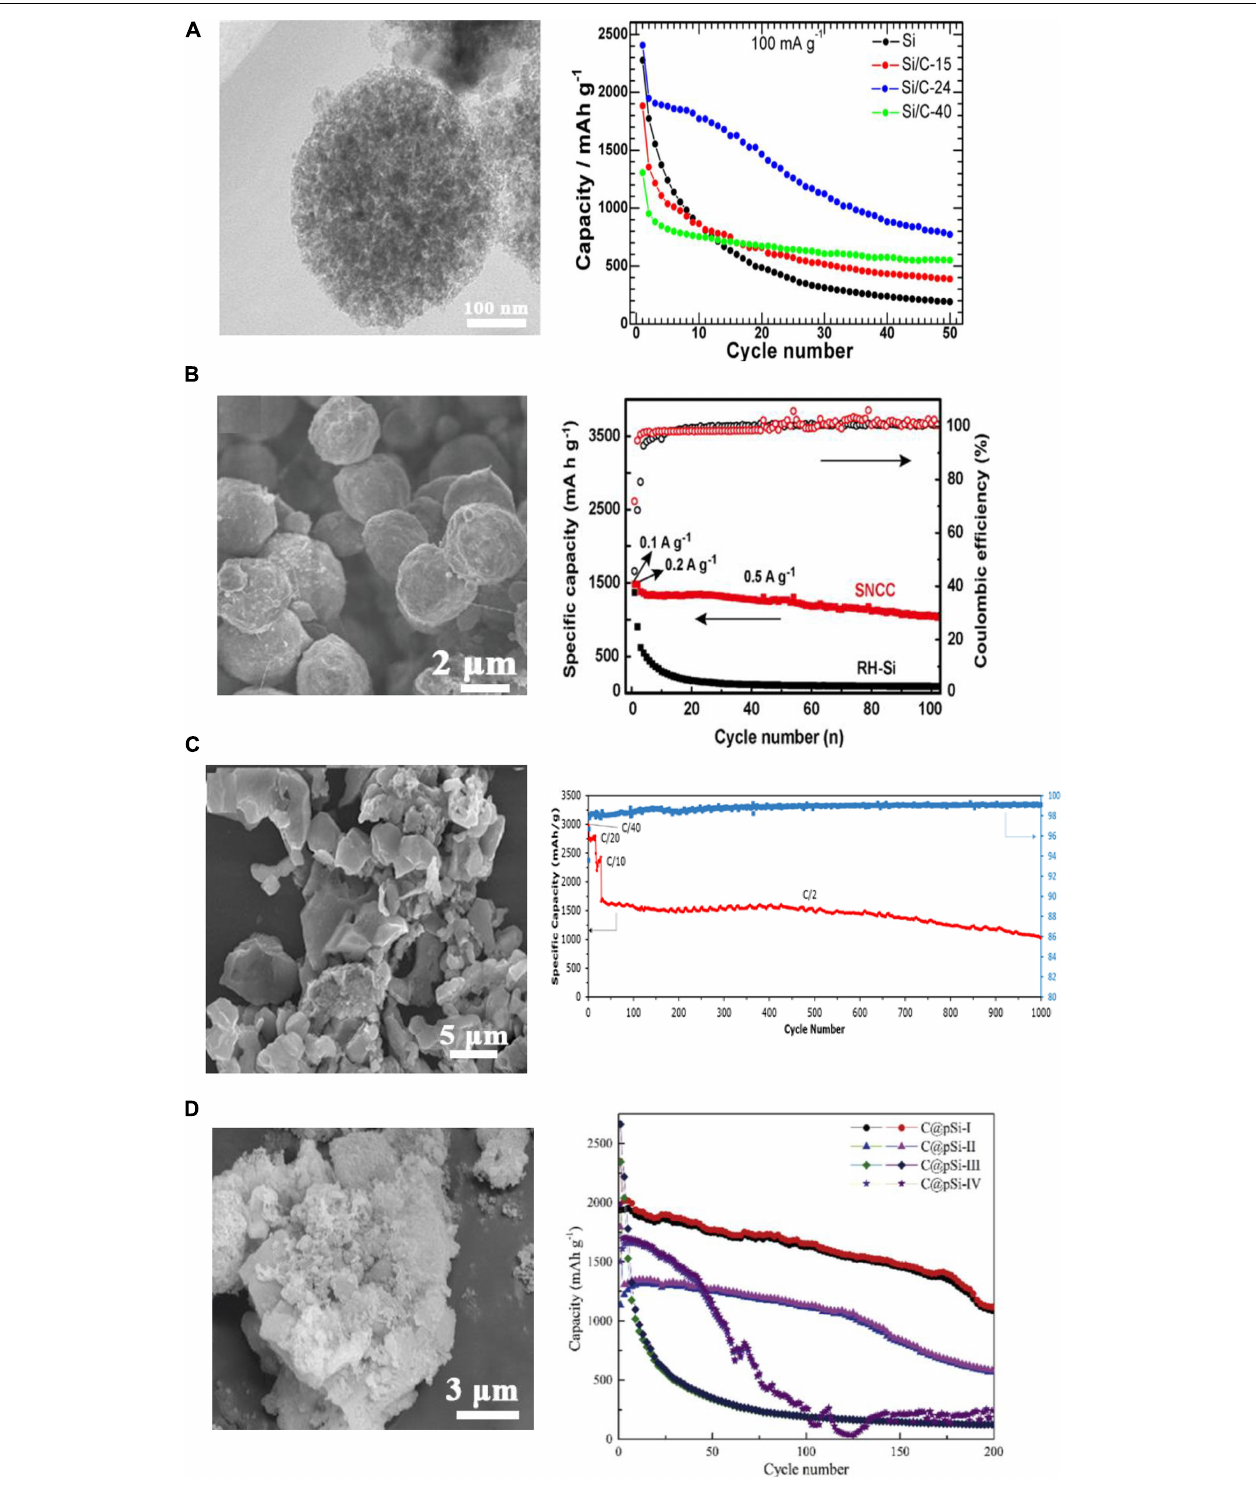
FIGURE 8 | SEM image and cycling performance of (A) Si/C spheres, reprinted from Ref. (Xie et al., 2014), with the permission of Elsevier. (B ) Si/C derived from rice husk, reprinted from Ref. (Zhang et al., 2016), with the permission of Elsevier. (C) porous Si@C from sand precursor, reprinted from Ref. (Favors et al., 2014), with the permission of Scientific Reports. (D) porous Si@C derived from clay. Reprinted from Ref. (Tang et al., 2018), with the permission of Elsevier.